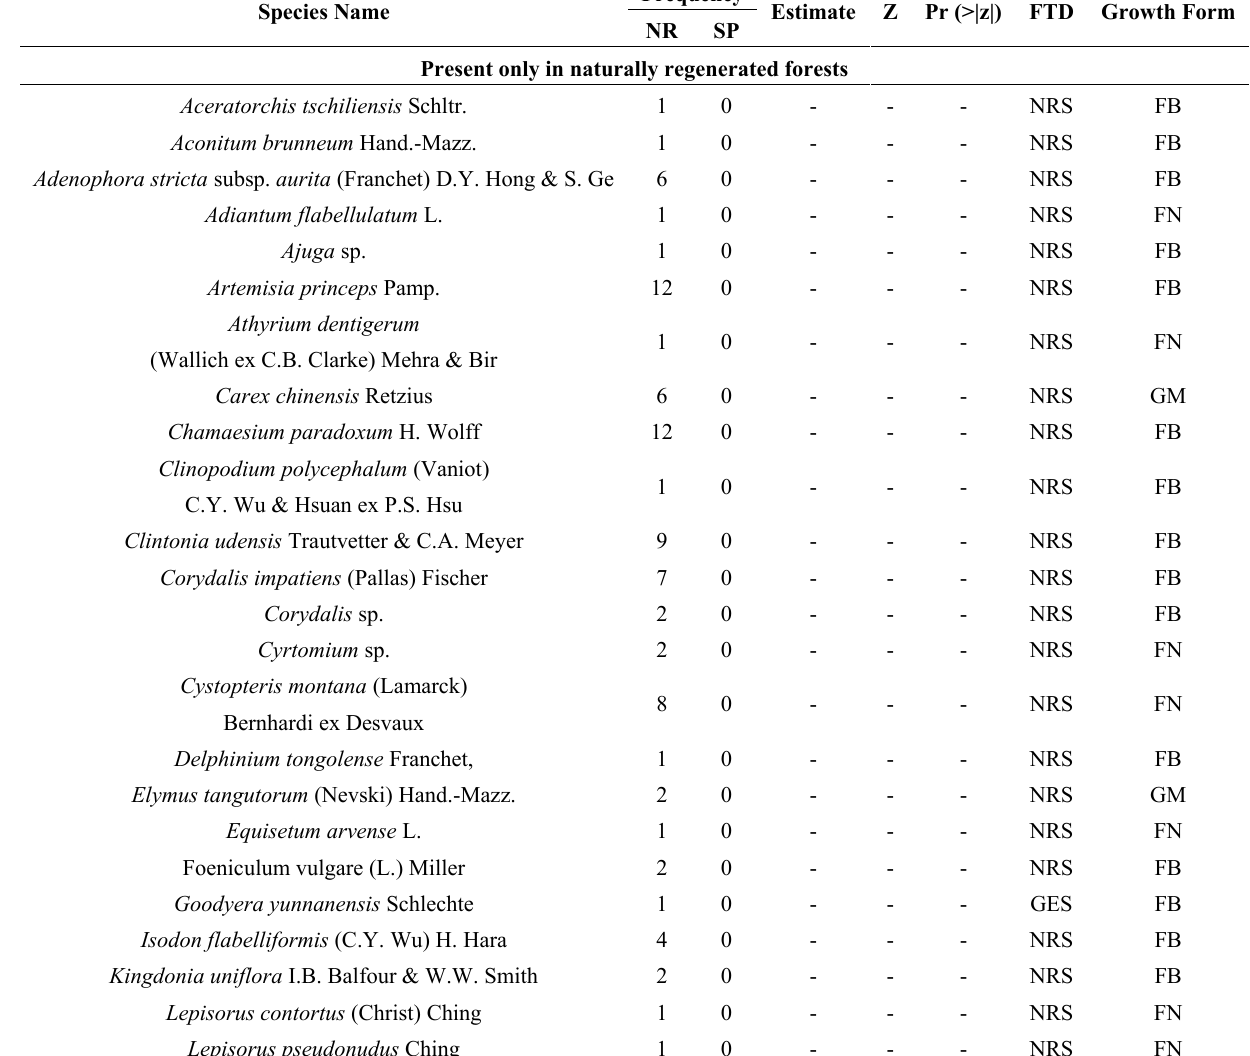
Table A3. Herbaceous plant species composition of the naturally regenerated forests (NR) and the artificial reforested spruce plantation (SP) originating from similar clear-cuts in the eastern Tibetan Plateau. The difference of frequency between the NR and the SP was tested by generalized linear mixed-effects models (GLMMs). Treatment (NR vs. SP) was introduced as fixed factor and stands (12 vs. 12) as random factor, three plots nested in each stand, and nine quadrats nested in each plot. In each case, binomial error distribution with logit-ling function for presence (1) and absence (0) was selected in GLMMs. Frequency tendency distribution (FTD): NRS, species only present or more frequent in naturally regeneration forests relative to reforested spruce plantations; RES, species only or more frequent in reforested spruce plantations species relative to natural stands; GES, generalist species. Growth-form: FB, forbs; FN, fern; GM,